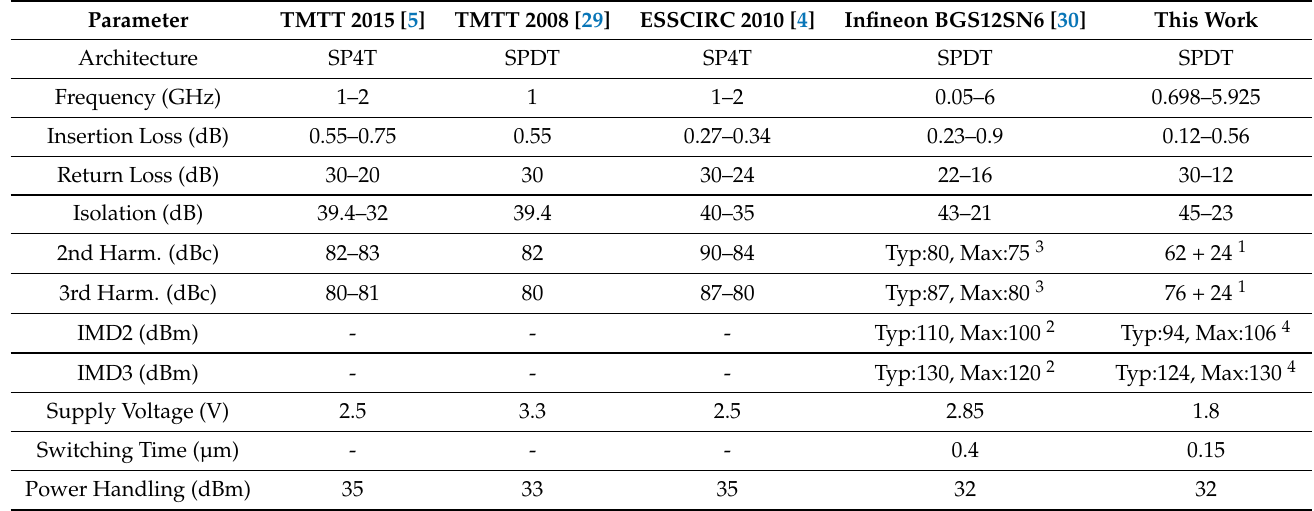
Table 3. Comparison with recent works and